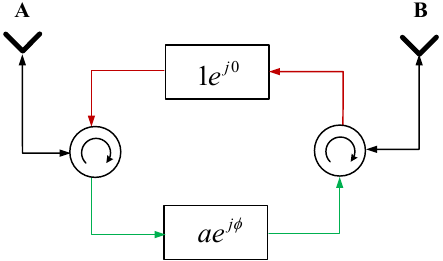
Figure 1. A retrodirective cross-eye jamming system with two antenna